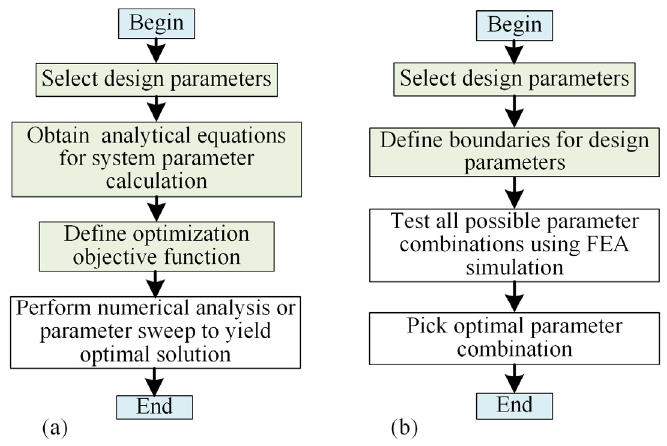
Figure 1. Optimization methodologies commonly adopted in the literature. ( a ) Analytical, equation- based optimization. ( b ) Finite element analysis-based optimization. based optimization. ( b ) Finite element analysis-based